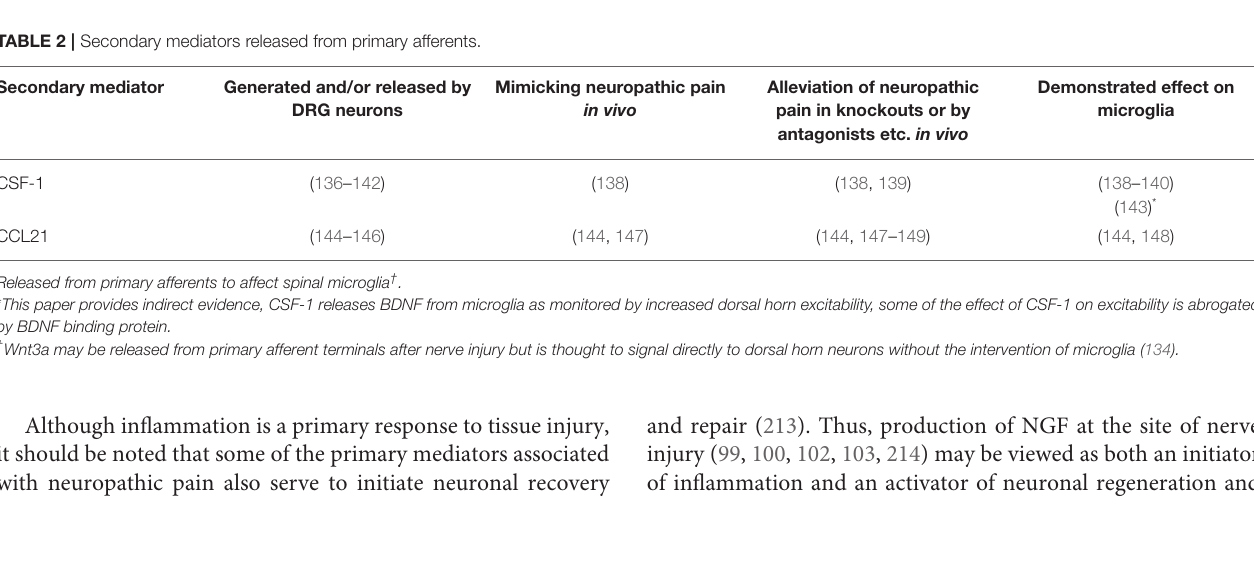
FIGURE 1 | Sites of action of primary, secondary, and tertiary mediators in signaling of neuropathic pain. Sources of primary mediators include Schwann cells (s), epithelial cells (e), mast cells (m-c), t-lymphocytes (t-l), macrophages (m), fibroblasts (f), and neutrophils (n).